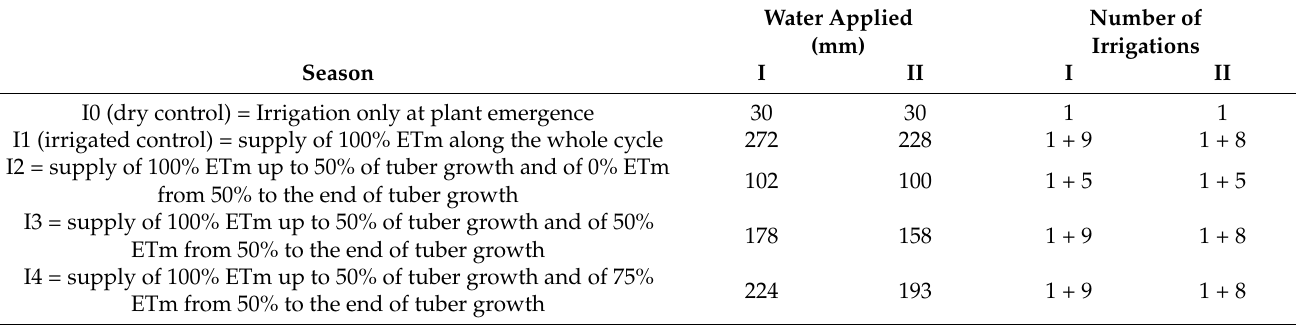
Table 1. Total water applied and number of irrigations in the studied irrigation treatments.